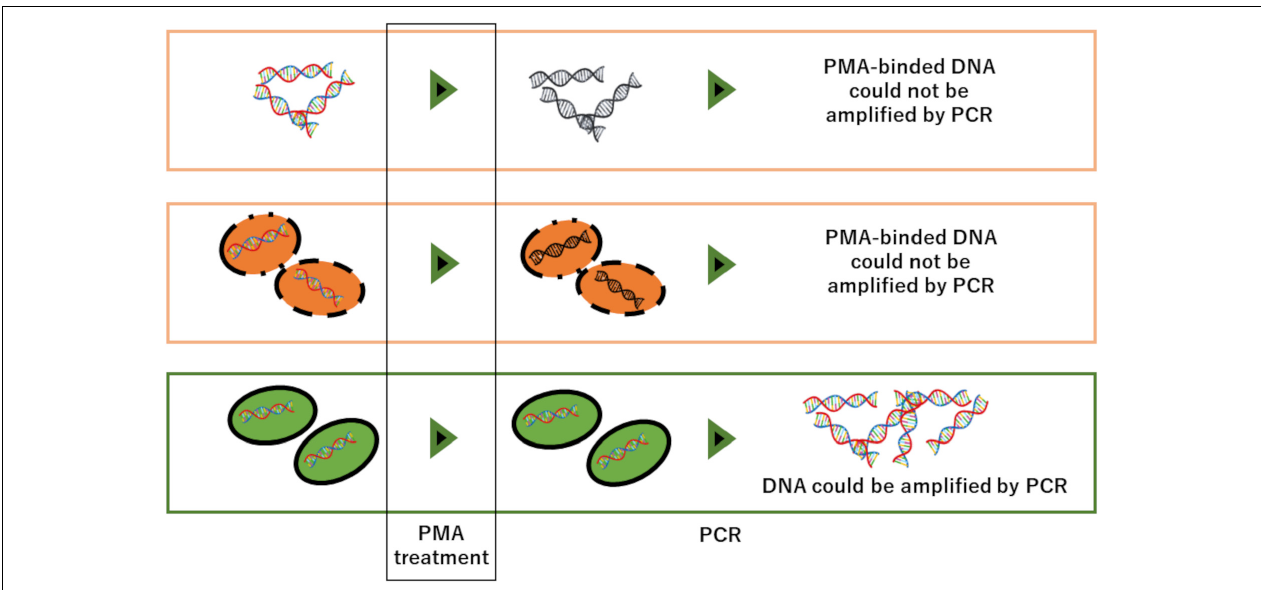
FIGURE 1 | Functional mechanism of PMA-DNA interaction: PMA-bound DNA cannot be amplified by PCR. The cell membrane is impermeable against PMA, thus DNA inside of intact cell membranes are protected from PMA-binding and can be selectively detected in PCR test.